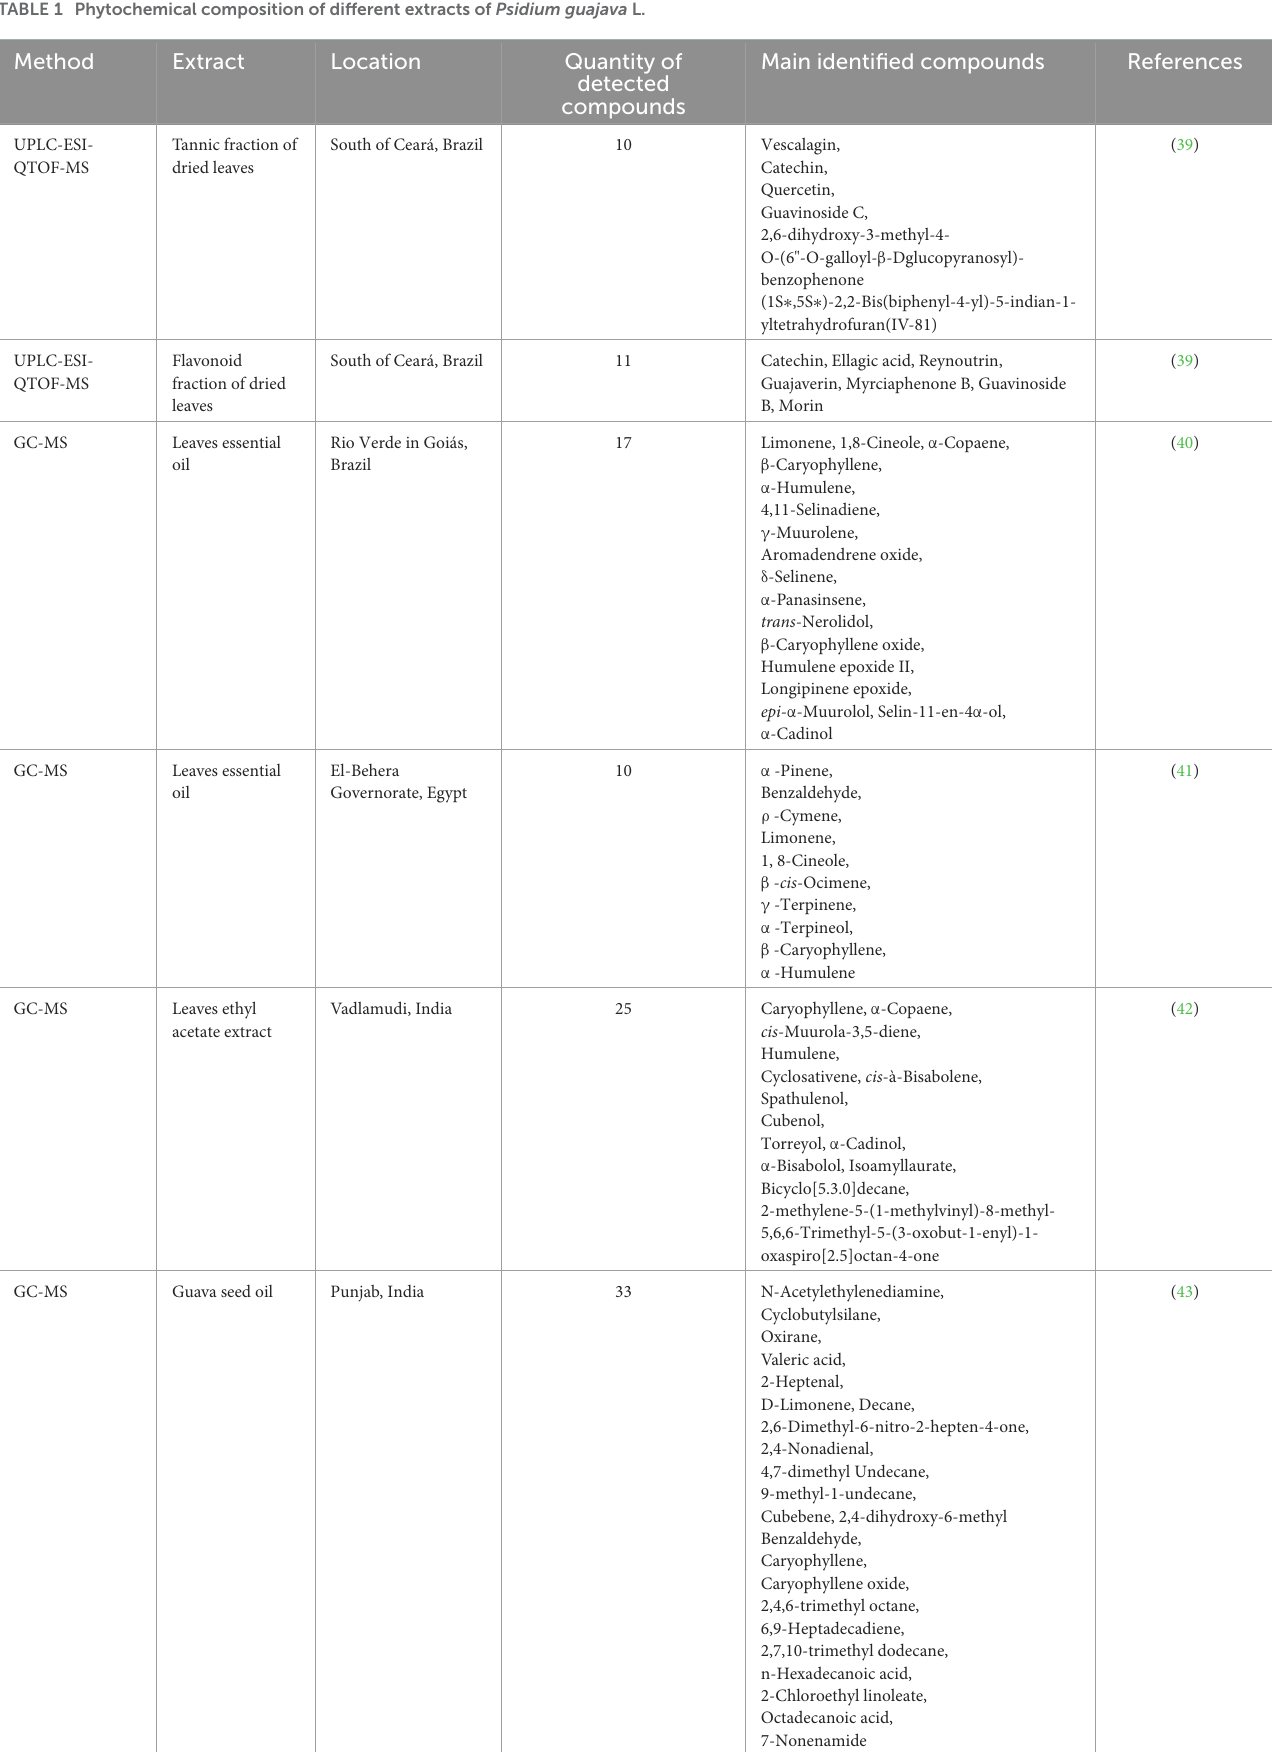
TABLE 1 Phytochemical composition of different extracts of Psidium guajava L.